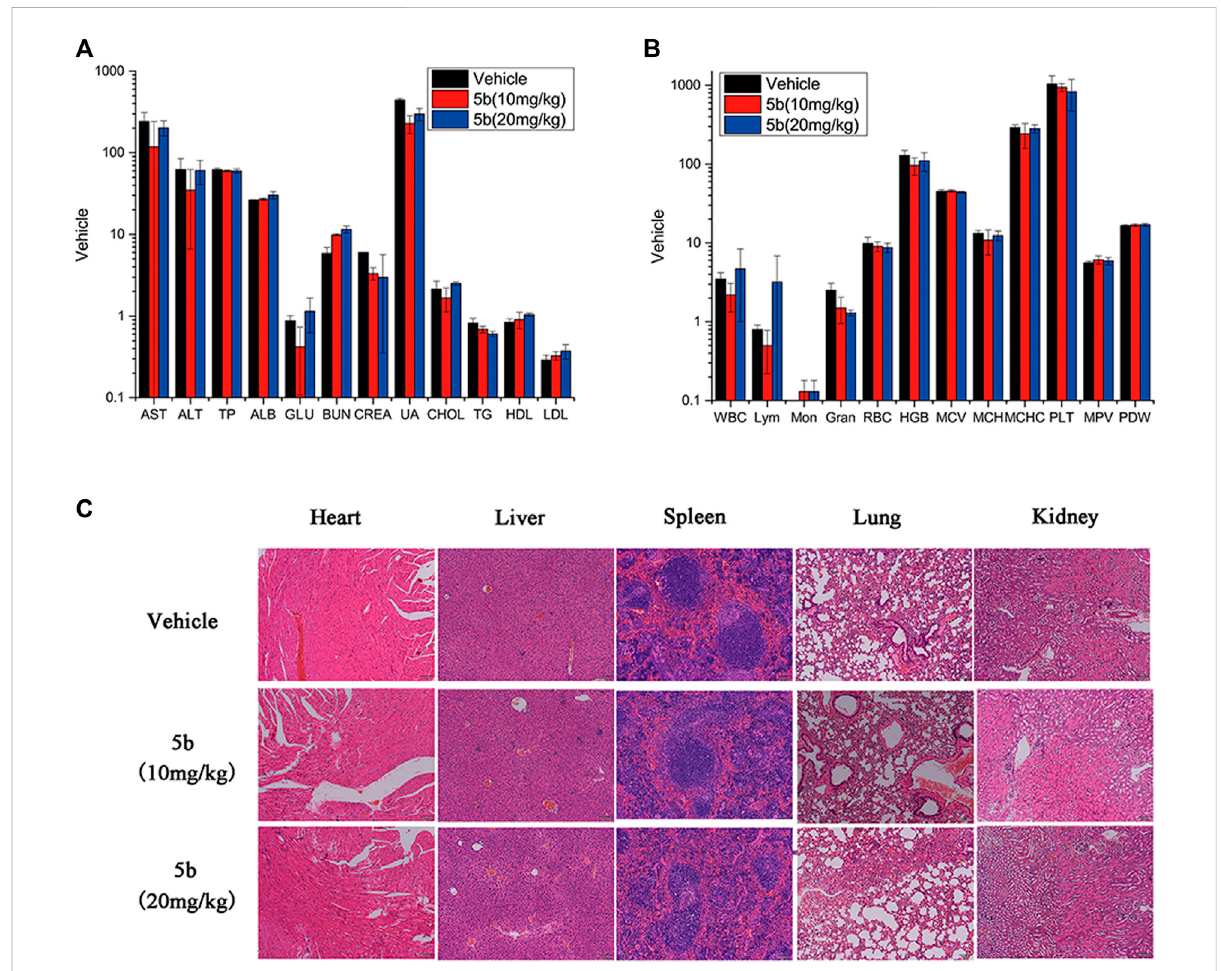
FIGURE 5 Evaluationofsideeffectsof 5b inmice. (A) Bloodchemistryanalysis. (B) Bloodroutineanalysis. (C) HEstainingofthesectionsoftheliver,kidney, spleen, lung, and heart from the mice in four groups after